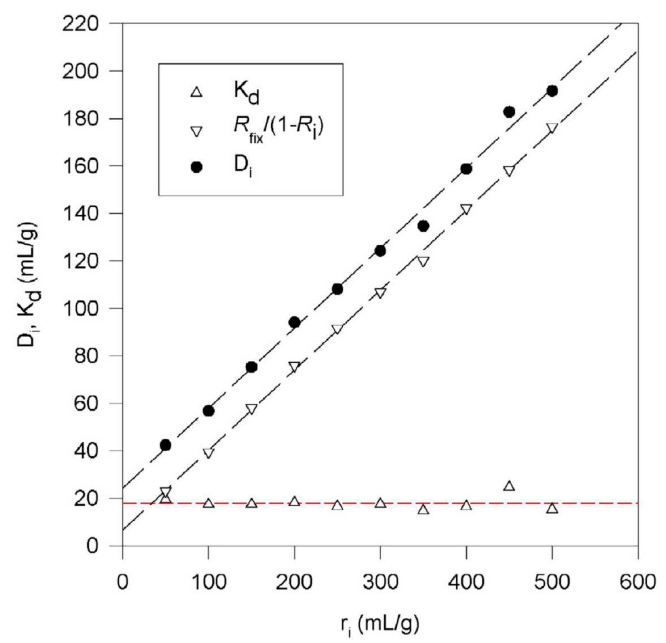
FIGURE 2. Radiocaesium leaching from montmorillonite by 1 M ammonium acetate at variable aqueous to solid phase ratios ( r i ), R f ix = 0.25, K d = 19 (for r = 100, E =